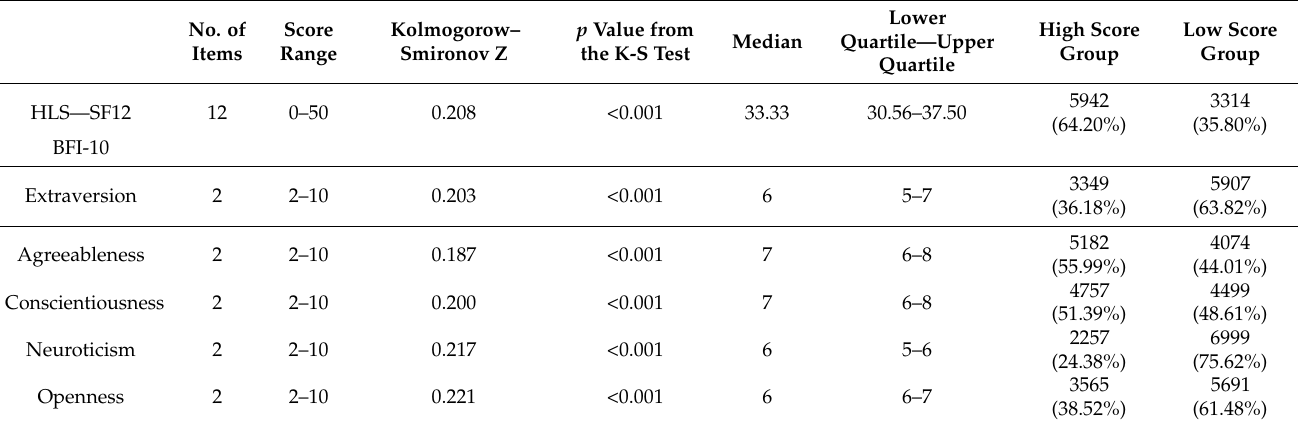
Table 2. Respondents’ scores on the HLS-SF12, BFI-10.